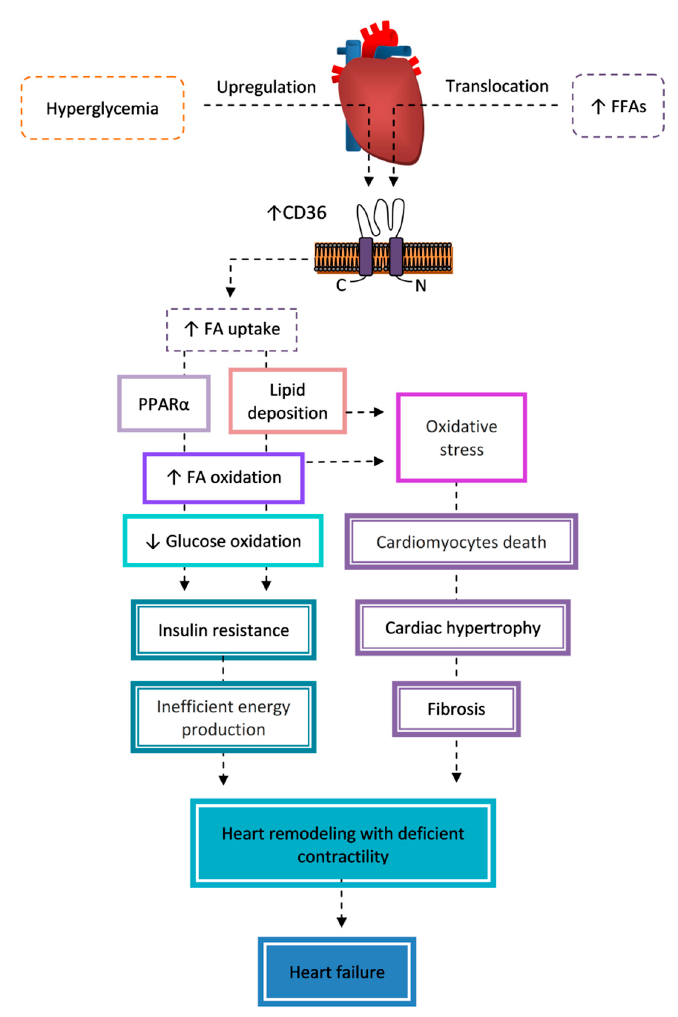
Figure 5. The contribution of CD36 to the pathogenesis of diabetic cardiomyopathy (DCM). The central event in the CD36-dependent mechanism of DCM pathogenesis is a persistent increase of CD36 expression in the plasma membrane, associated with the influx of fatty acids (FAs) into cardiomyocytes and lipid deposition. Some of the effects are an alteration of cardiomyocyte energy metabolism to the utility of FAs, and a decrease of glucose oxidation, which promotes ineffective energy production. The other is oxidative stress, caused by accumulated lipids and FA oxidation, stimulating cardiomyocyte death, hypertrophy, and fibrosis. They are followed by heart remodeling, deficient contractility, and ultimately heart failure.